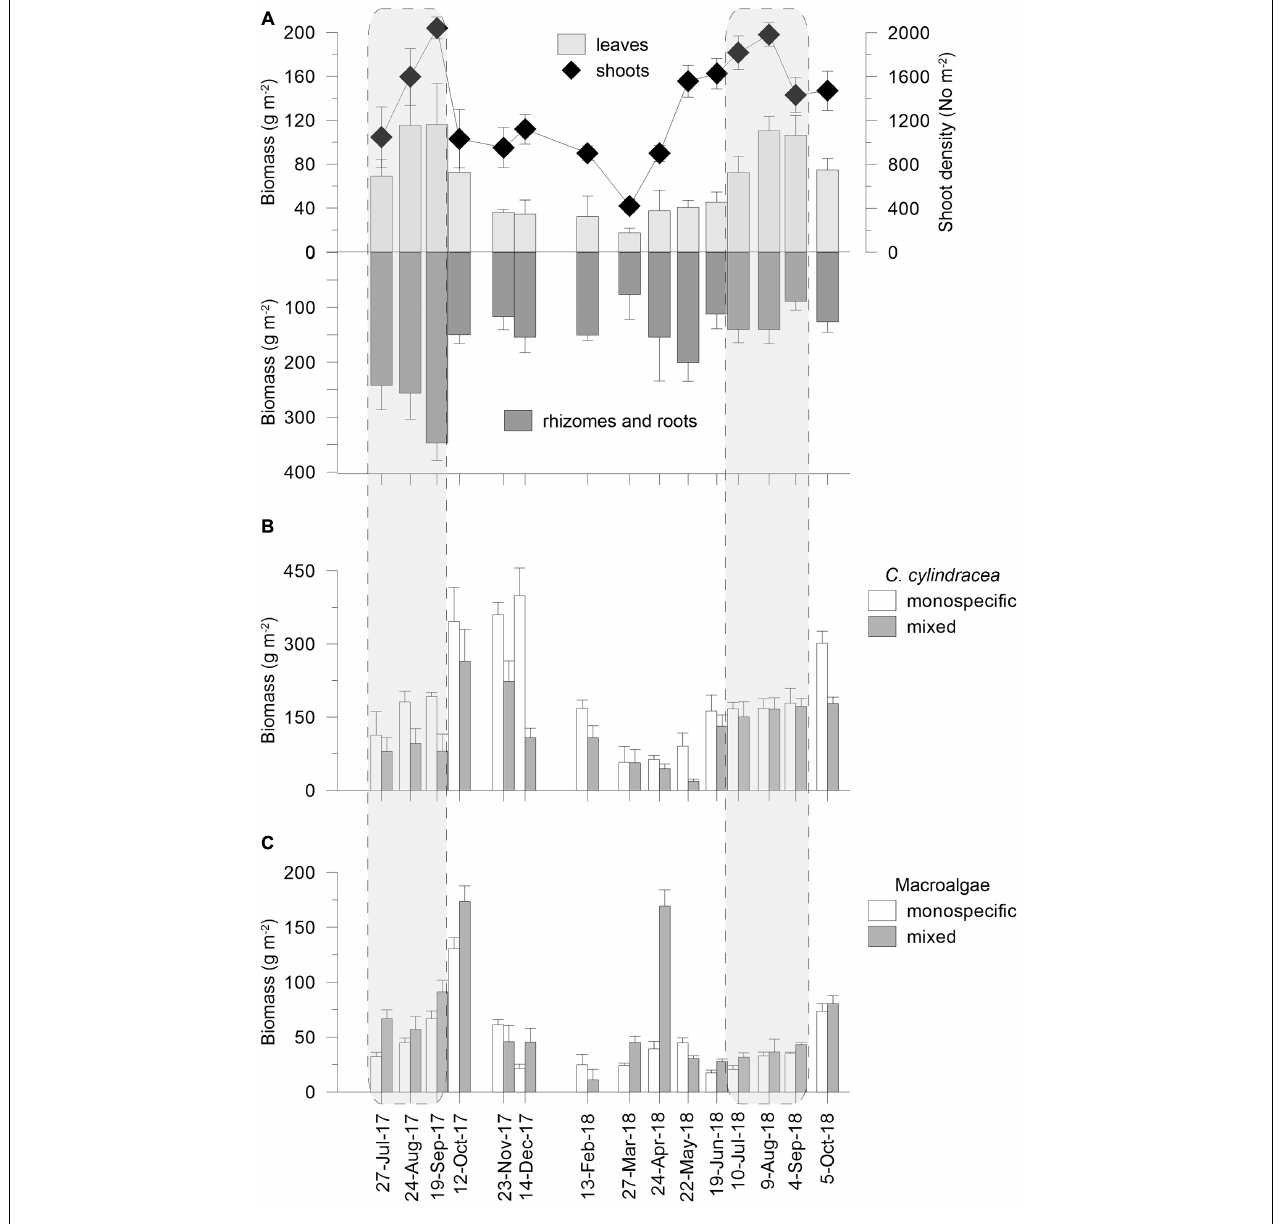
FIGURE 3 | Above- and below-ground biomass and shoot density of C. nodosa in the meadow invaded by C. cylindracea —mixed settlement (A) , biomass of C. cylindracea in its monospecific and in the mixed settlement (B) ; biomass of macroalgae in the C. cylindracea monospecific settlement and in the mixed settlement (C) , during investigated period. Data are presented as mean ± SD ( n =